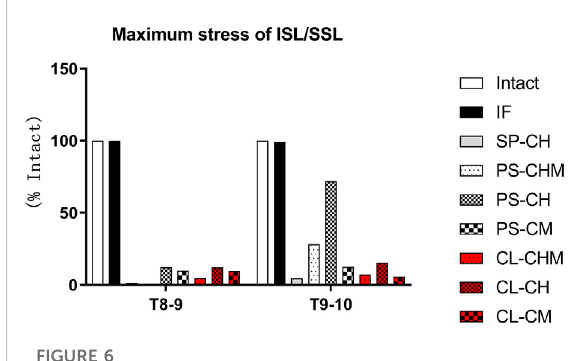
FIGURE 6 Maximum stress of the ISL/SSL (% of maximum stress of the ISL/SSL in model intact), measured at T8 – 9 and T9 – 10 segments for intact, IF, SP-CH, PS-CHM, PS-CH, PS-CM, CL-CHM, CL-CH, and CL-CM